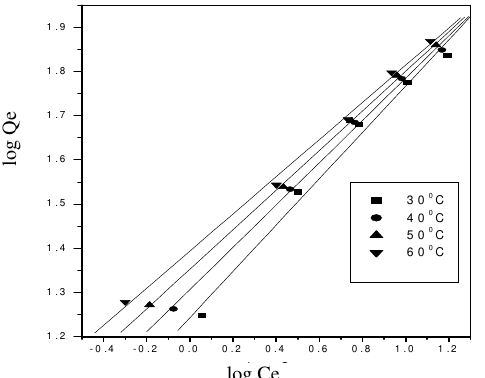
Figure 4 . Linear Freundlich isotherm for the adsorbent of malachite green onto SDC Table 3. Langmuir isotherm results Temp Statistical parameters/constants